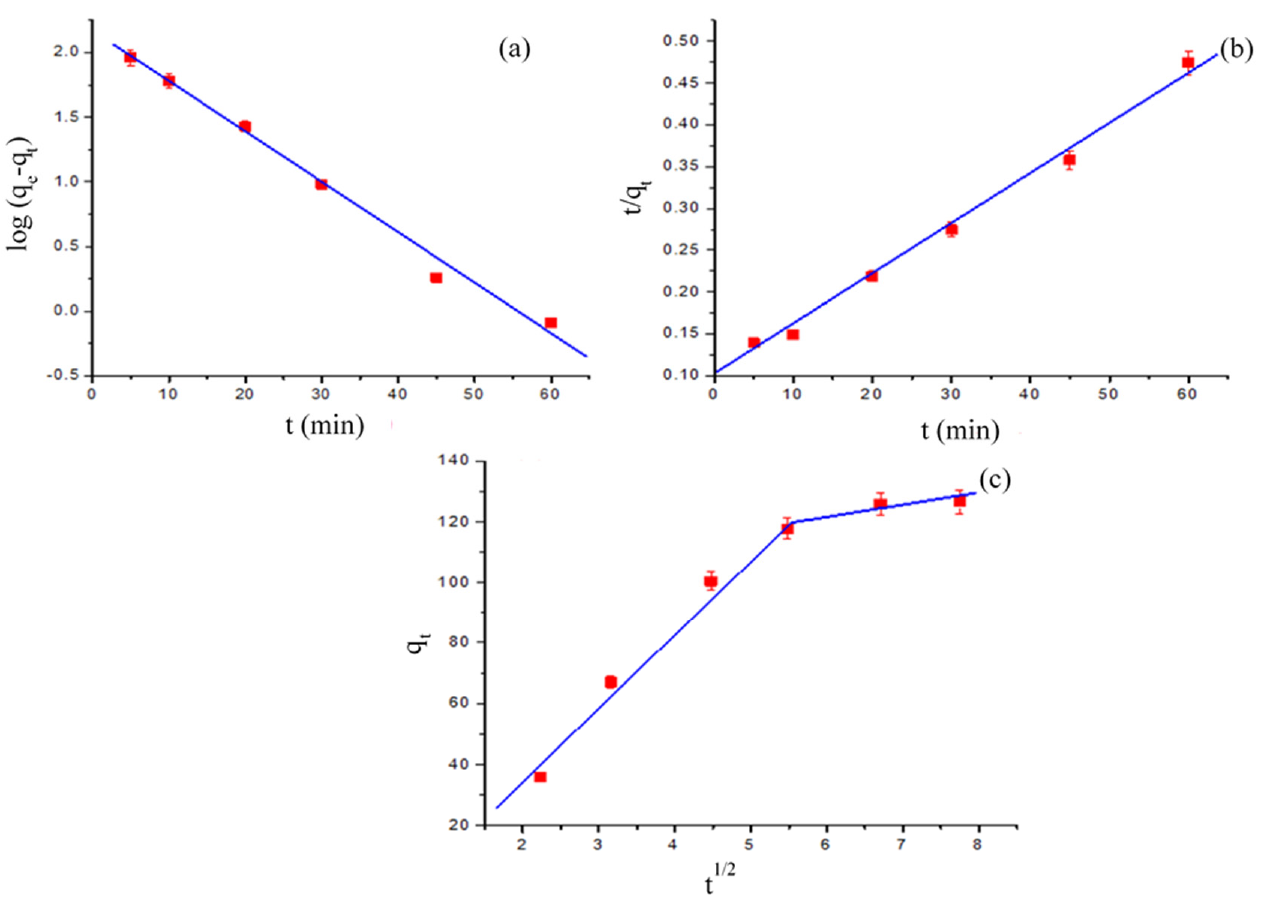
Figure 6. Pseudo-first-order kinetic plot ( a ), pseudo-second-order kinetic plot ( b ), and intraparticle diffusion plot ( c ) for BG adsorption on GO-PANI.